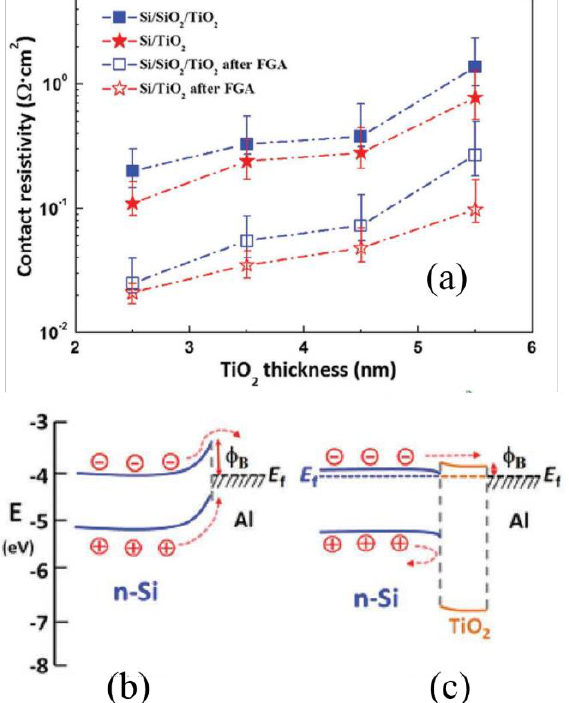
Figure 9. ( a ) The contact resistivity dependence on the thickness of the TiO 2 layer before and after forming gas annealing (FGA). The Si/TiO 2 interface exhibits good passivation and relatively low contact resistivity. ( b ) and ( c ) Band gap alignments with and without TiO x interlayer between the silicon wafer and Al [134]. A minus sign in the circle represents the electron, and a plus sign represents the hole. With the insertion of the TiO x layer, the decreased φ B could favor the electrons to be collected and holes to be blocked, showing the electron-selective property of TiO 2